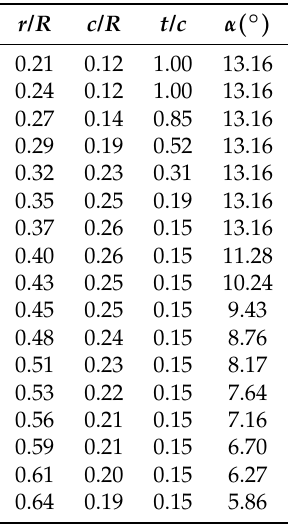
Table A1. Characteristics of RM1 turbine blades (NACA-4415). A circular blade root was used to allow for manual pitch